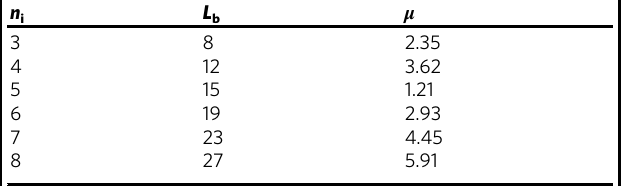
Table 1 Threshold theory boundary